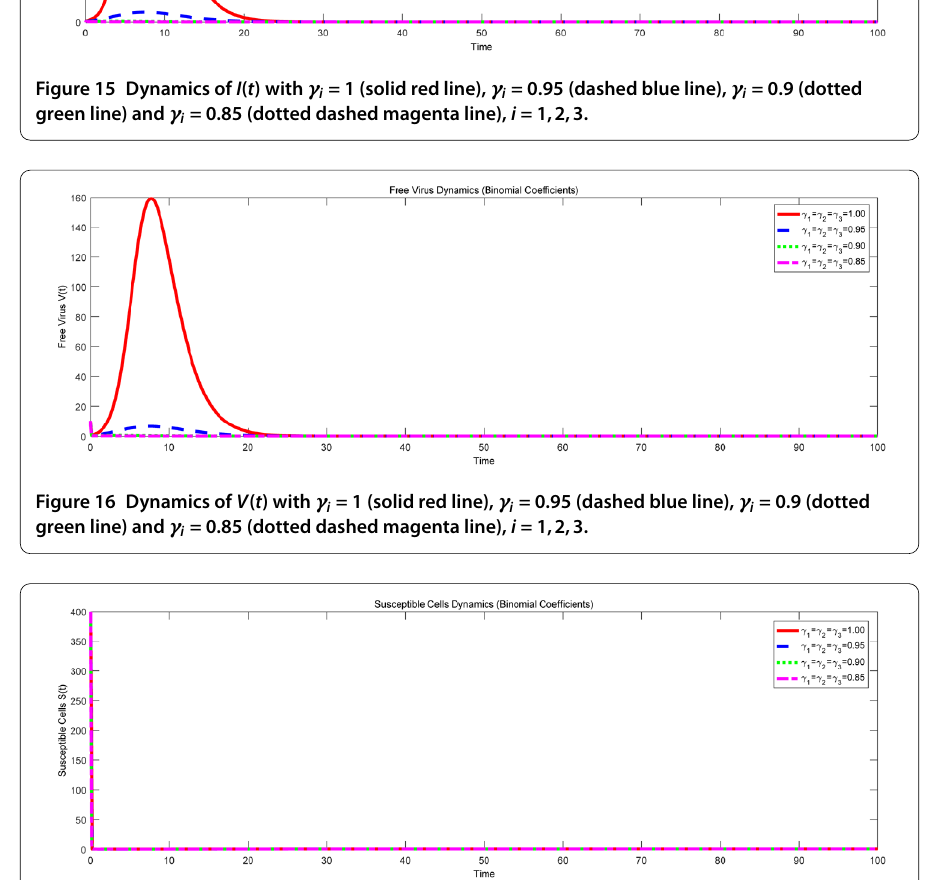
Figure 17 Dynamics of S ( t ) with γ i = 1 (solid red line), γ i = 0.95 (dashed blue line), γ i = 0.9 (dotted green line) and γ i = 0.85 (dotted dashed magenta line), i =